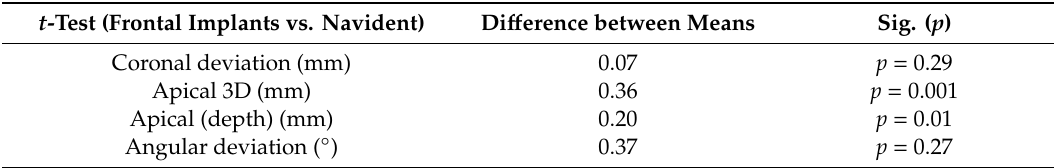
Table 6. t -test showing the di ff erence between the means of pterygoid and frontal implants. The di ff erence was considered statistically significant for a value of p < 0.05. t -Test (Frontal Implants vs.